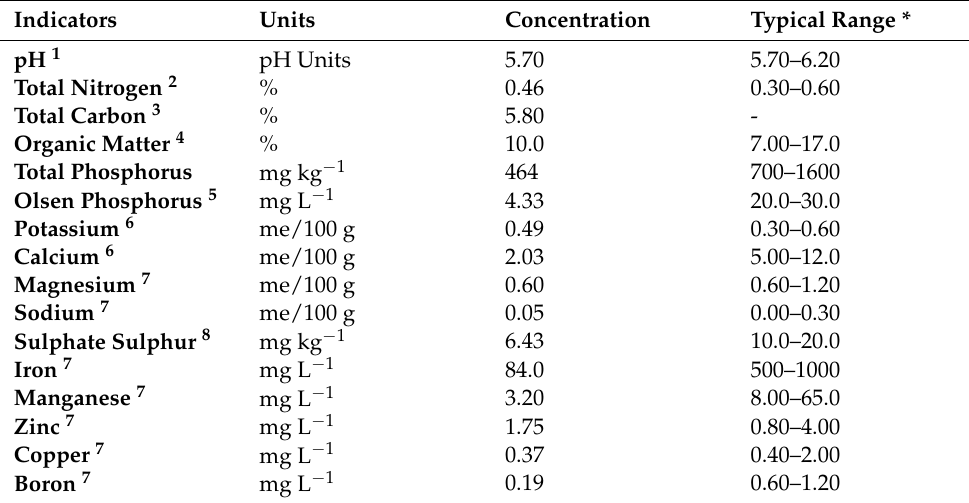
Table 1. Analysis of physico-chemical determinants in the experimental soil. Indicators Units Concentration Typical Range * pH 1 pH